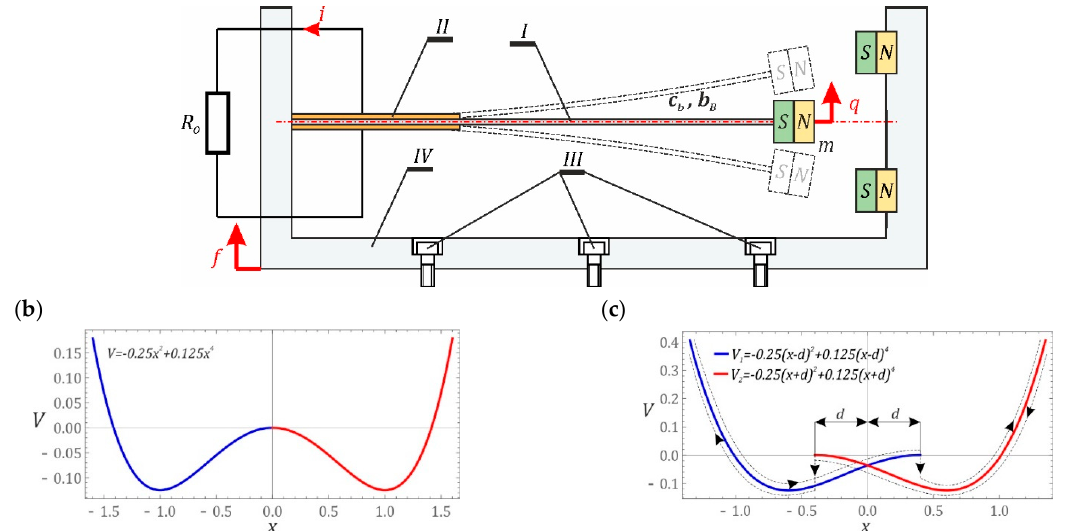
Figure 1. System and its potential characteristics: ( a ) schematic diagram without indicating the origin of hysteresis, modelling of the hysteretic branches: ( b ) potential without hysteresis loop, ( c ) with hysteresis loop, d indicates the overlap shift, q is the displacement of the tip point of the beam. i is the current in the electrical circuit.